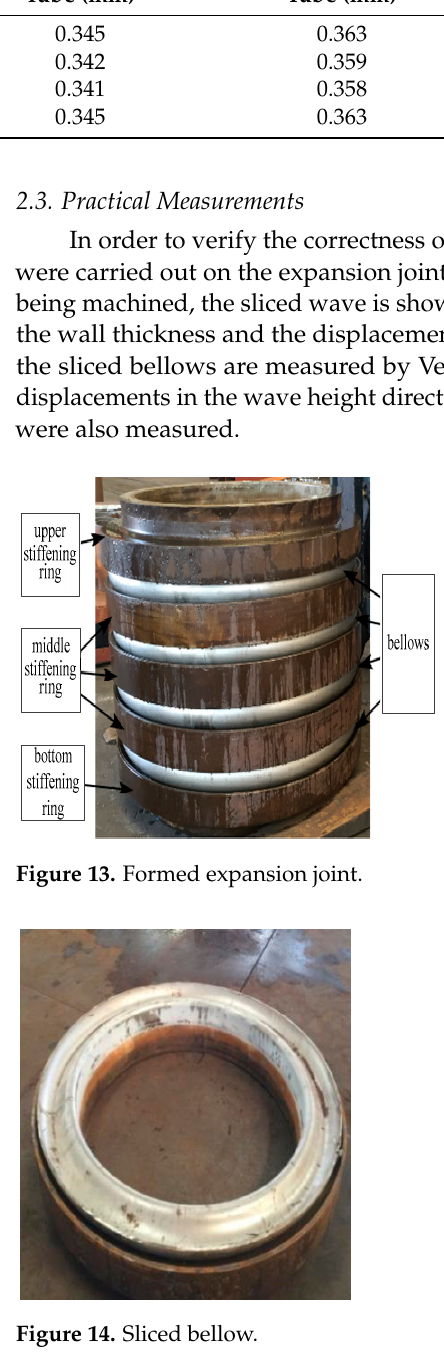
Table 4. Comparisons between simulation results and experimental results of the first wave.